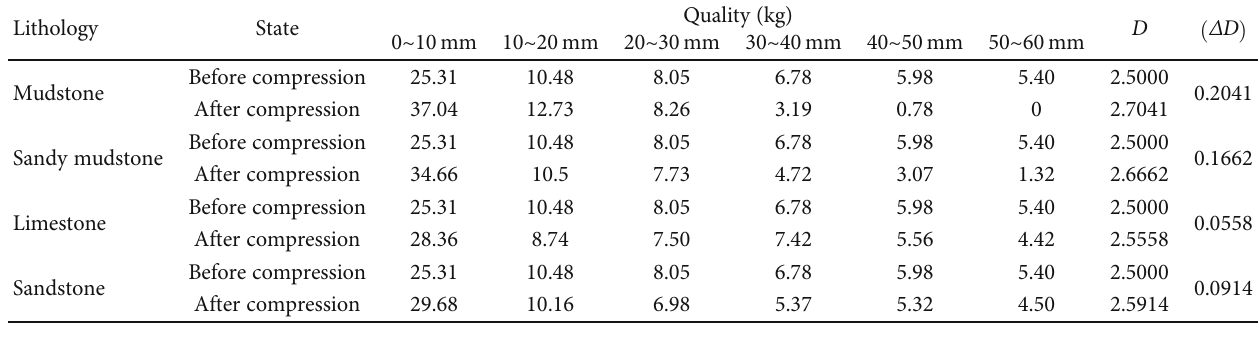
Table 3: Grain size distribution and fractal dimensions of crushed rock of di ff erent lithology before and after compression (axial stress of 3.5MPa).